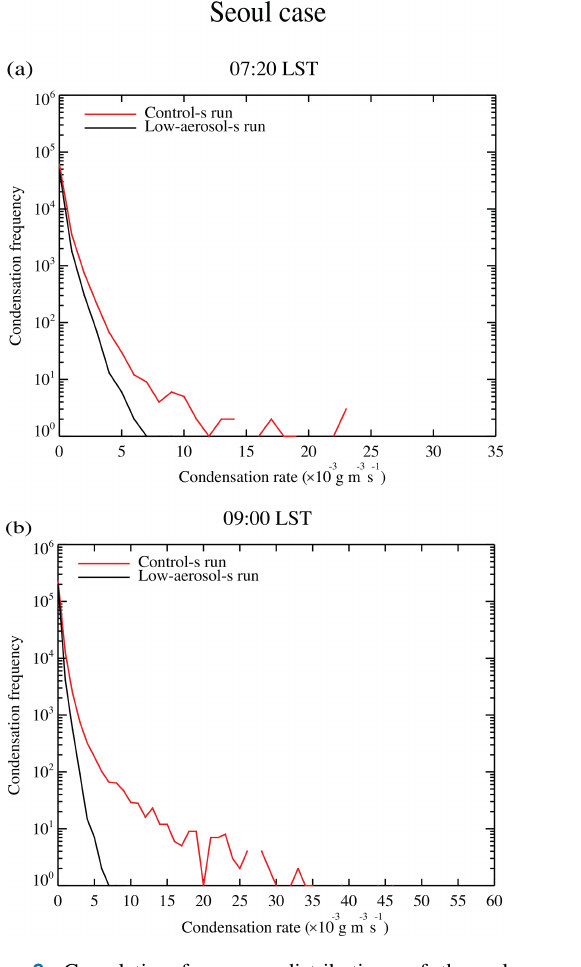
Figure 8. Cumulative frequency distributions of the column- averaged condensation rates in the control-s and low-aerosol-s runs for the Seoul case at (a) 07:20LST and (b)